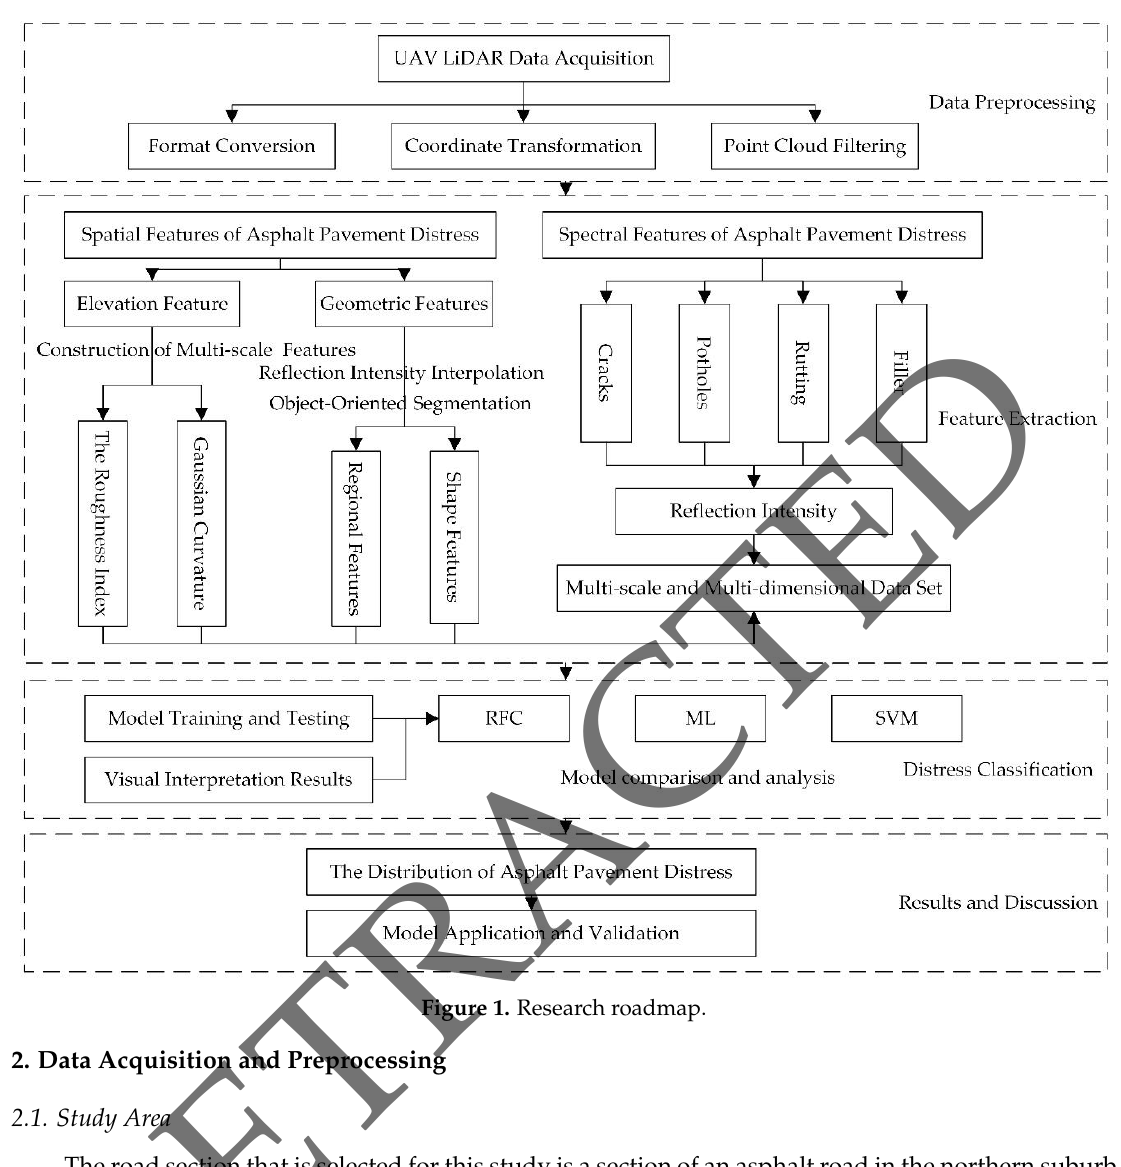
Figure 1. Research Figure 1. Research roadmap.